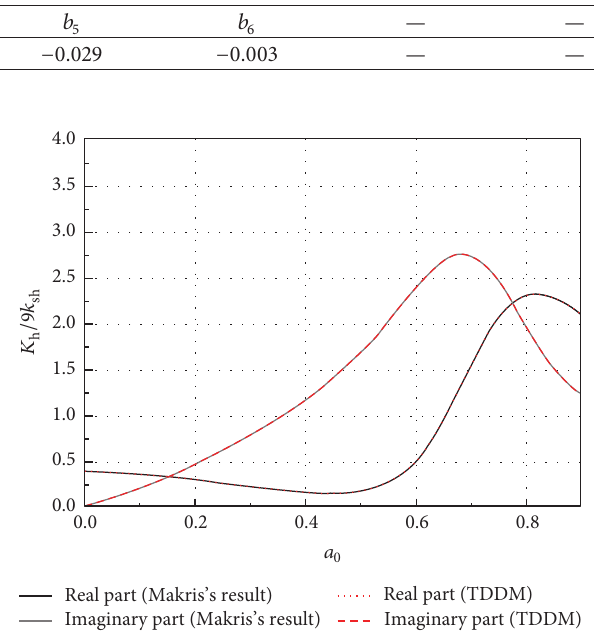
Figure 4: Normalized dynamic stiffness of pile group foundation reported by Du and Zhao